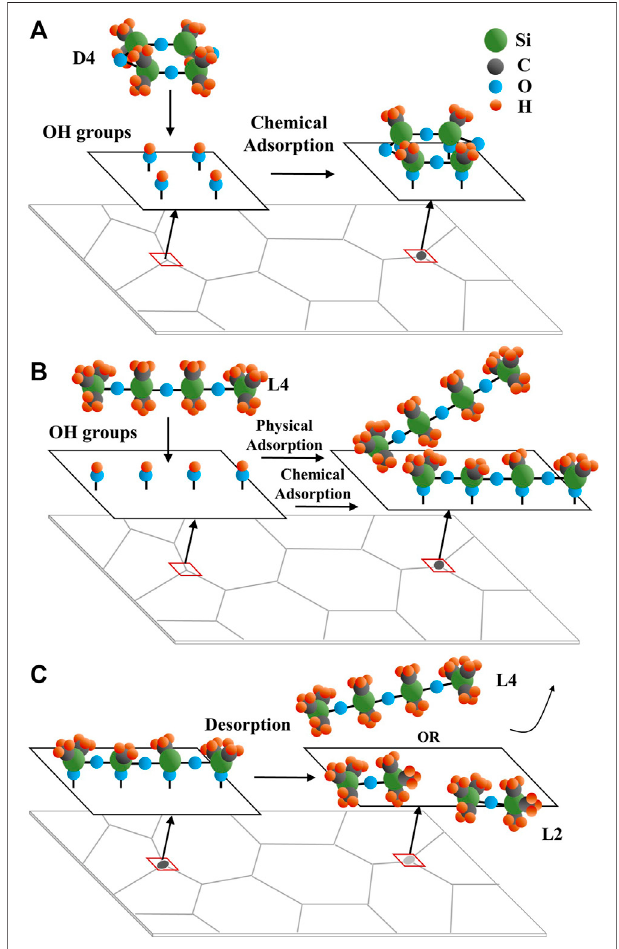
FIGURE 12 | D4/L4 chemical adsorption and desorption on the YSZ pellet surface.